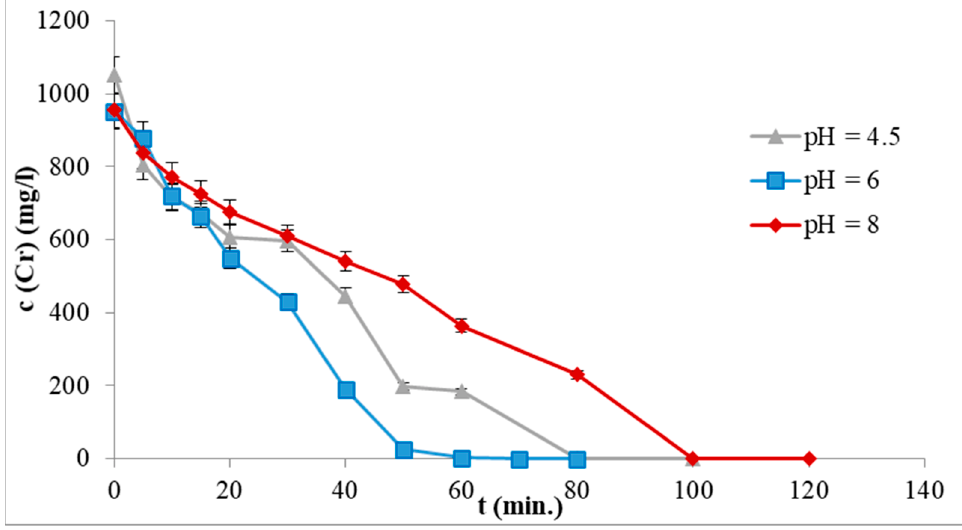
Figure 2. Decrease of Cr concentration in model solutions for different pH values, c (NaCl) = 3000 mg/L, I = 1 A .